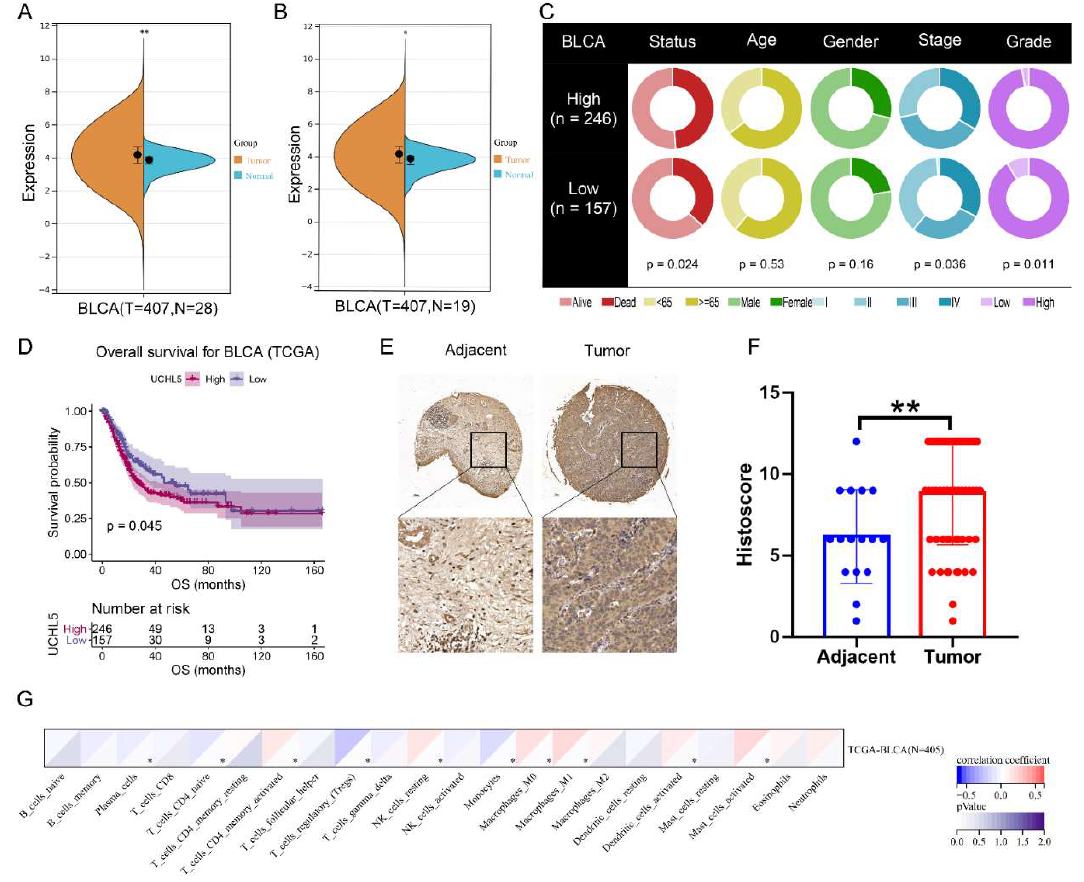
Figure 1. Expression of UCHL5 in bladder cancer. Differences in expression of UCHL5 between ( A ) ladder cancer (BLCA) samples ( n = 407) and normal samples (n = 28) using TCGA (matched samples, n = 19) and GTEx databases (healthy tissue, n = 9). ** p < 0.01; ( B ) bladder cancer (BLCA) samples ( n = 407) and matched samples ( n = 19) using TCGA database. * p < 0.05. ( C ) The differences in clinical features (living status, age, gender, stage, and grade) across UCHL5 high- and low-expression groups in the TCGA cohort. ( D ) Overall survival curve across UCHL5 high- and low-expression groups in the TCGA cohort. The p -value is indicated. ( E ) Representative IHC images for UCHL5 in tissue microarrays containing tumor tissue samples and normal bladder tissue samples. ( F ) Tissue microarray data analysis of UCHL5 expression in 63 bladder cancer tissue samples and 16 adjacent bladder tissue samples. ** p < 0.01. ( G ) Association of UCHL5 expression with 22 immune cell infil- tration levels defined by CIBERSORT algorithm. Values are shown as mean ± SD. * p < 0.05 and ** p < 0.01 compared with controls.